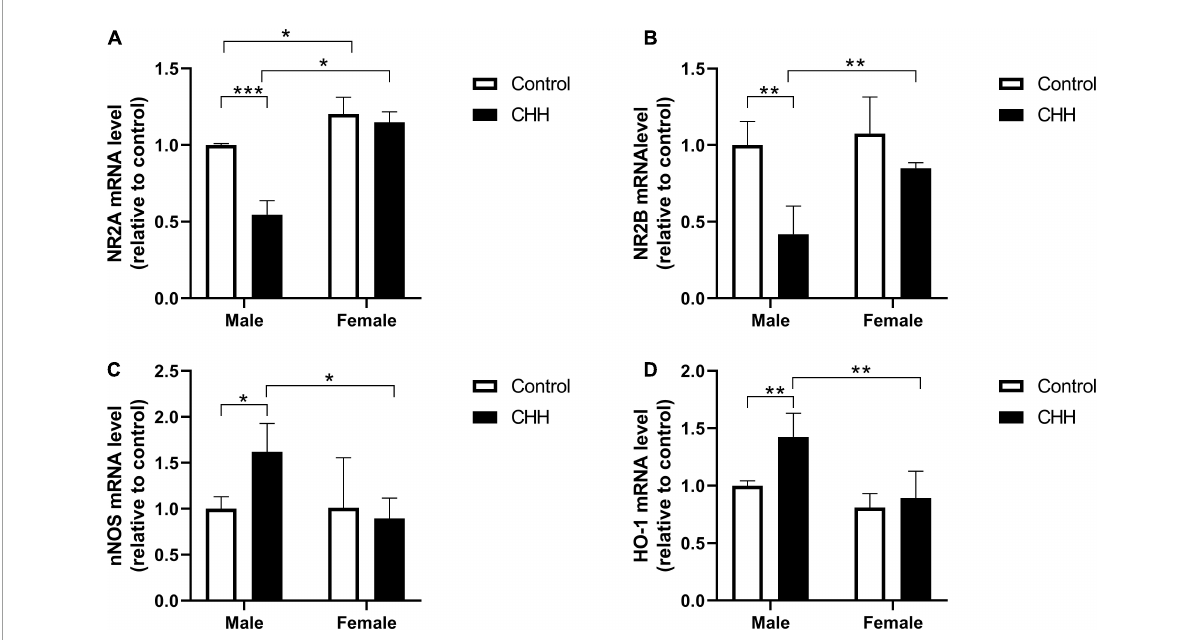
FIGURE10 Quantitative analysis of NR2A, NR2B, nNOS, and HO-1 mRNA in the hippocampus of male and female CHH and control rats. CHH exposure reduced the gene expression of N -methyl- D -aspartate receptor (A) NR2A and (B) NR2B subunits and increased the gene expression of (C) nNOS and (D) HO-1 in male rats’ hippocampus. Values are means ± SD for four animals/group. Data for male and female rats, with or without CHH exposure, were analyzed using two-way ANOVA. Post hoc analysis indicated: * p < 0.05, ** p < 0.01, *** p < 0.001.